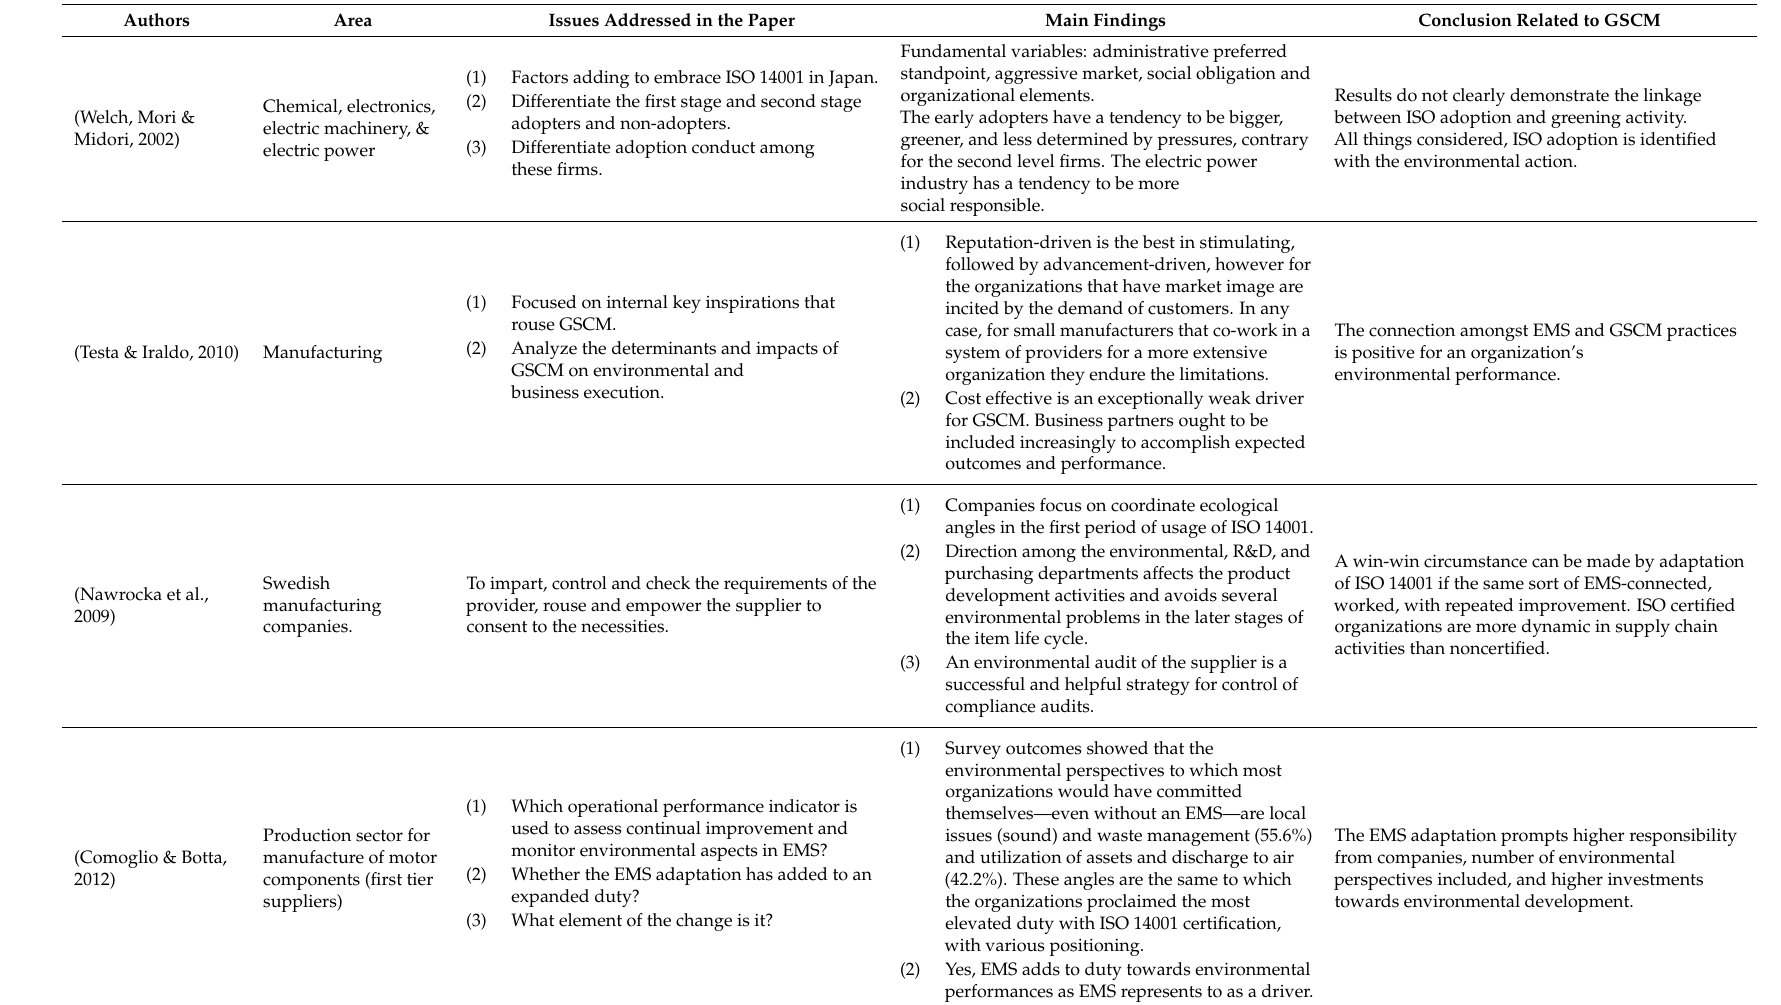
Table 2. Technique and factors for